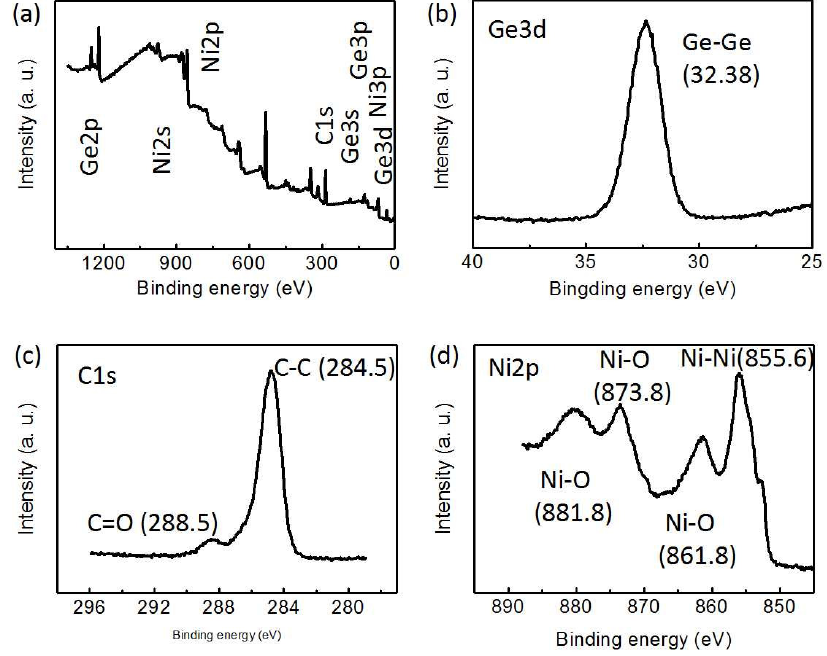
Figure 9. XPS survey: ( a ) the Ge composite film growing on the graphite, ( b ) the Ge 3d peak, ( c ) the C 1s peak, and ( d ) the Ni 2p